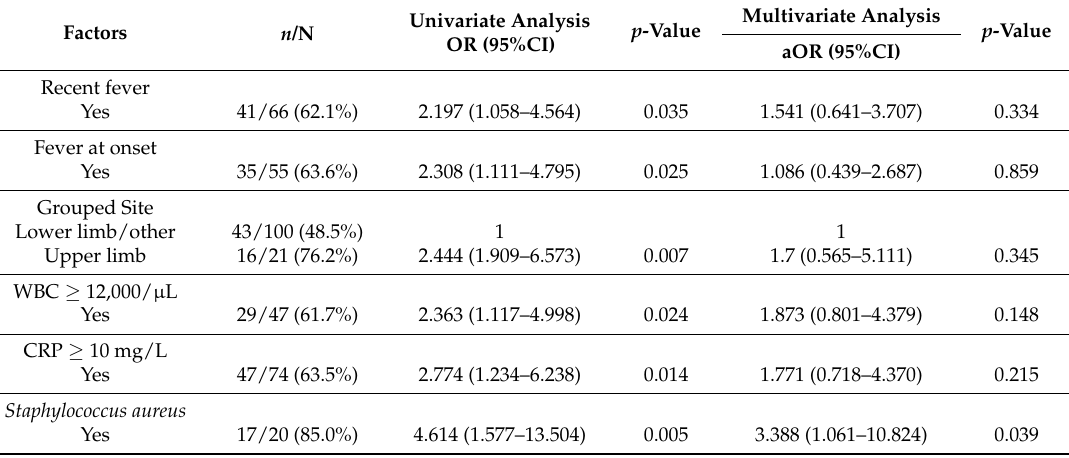
Table 2. Factors associated with complicated acute osteomyelitis at uni- and multi-variate